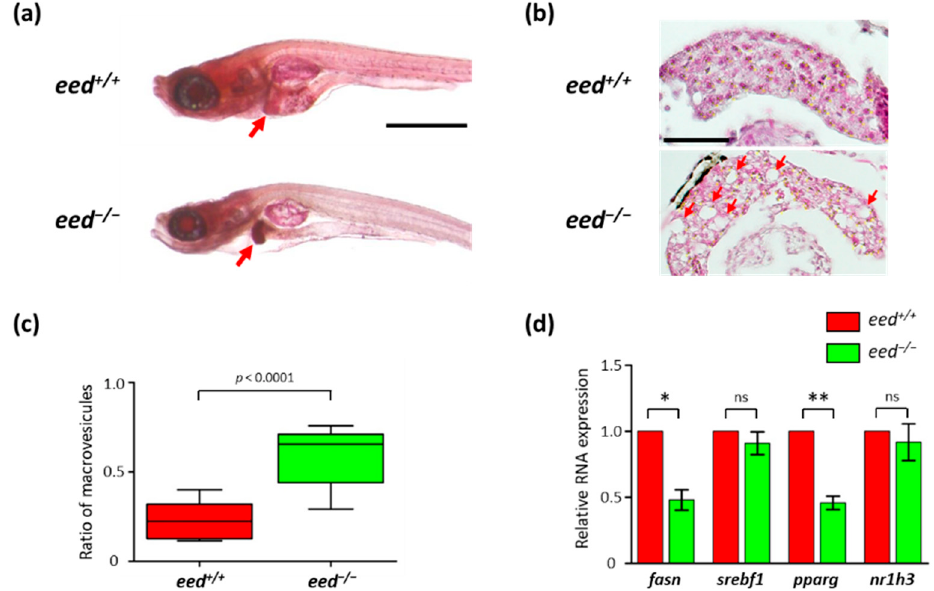
Figure 6. Liver alterations in eed ‐ deficient larvae: ( a ) representative images of lateral views of eed +/+ and eed ‐ / ‐ larvae stained with oil red ‐ O at 11 dpf. The red arrow shows the liver. Scale bar is 500 μ m; ( b ) histological sections stained with hematoxylin and eosin showing the liver of eed +/+ and eed ‐ / ‐ larvae at 11 dpf. Red arrows show macrovesicles. Scale bar is 50 μ m; ( c ) quantification of macrovesicular steatosis eed +/+ (red) and eed ‐ / ‐ (green) larvae at 11 dpf. The ratio of macrovesicular structures relative to total hepatic surface was calculated on 3 histological slices per larvae from 4 different larvae per genotype. Statistical significance was assessed using a Mann–Whitney t ‐ test; ( d ) relative levels of fasn , srebf1 , pparg, and nr1h3 RNA abundances in 9 dpf old eed +/+ (red) and eed ‐ / ‐ (green) larvae quantified by RT ‐ qPCR. Three independent experiments were performed, and error bars represent standard deviation. Statistical analysis was performed using a one ‐ way ANOVA test followed by a Dunn’s multiple test comparison; ns, non ‐ significant; *, p < 0.05; **, p < 0.01.